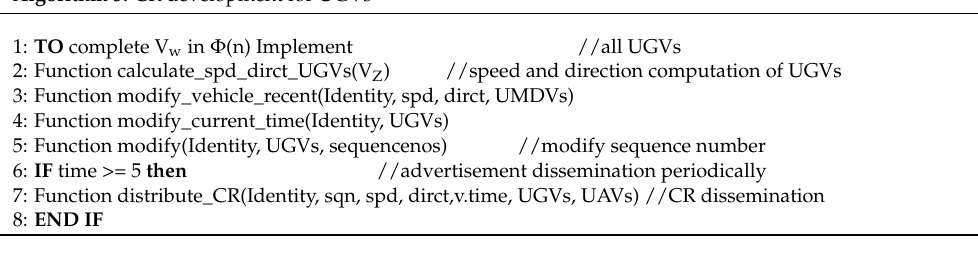
Algorithm 3. CR development for UGVs